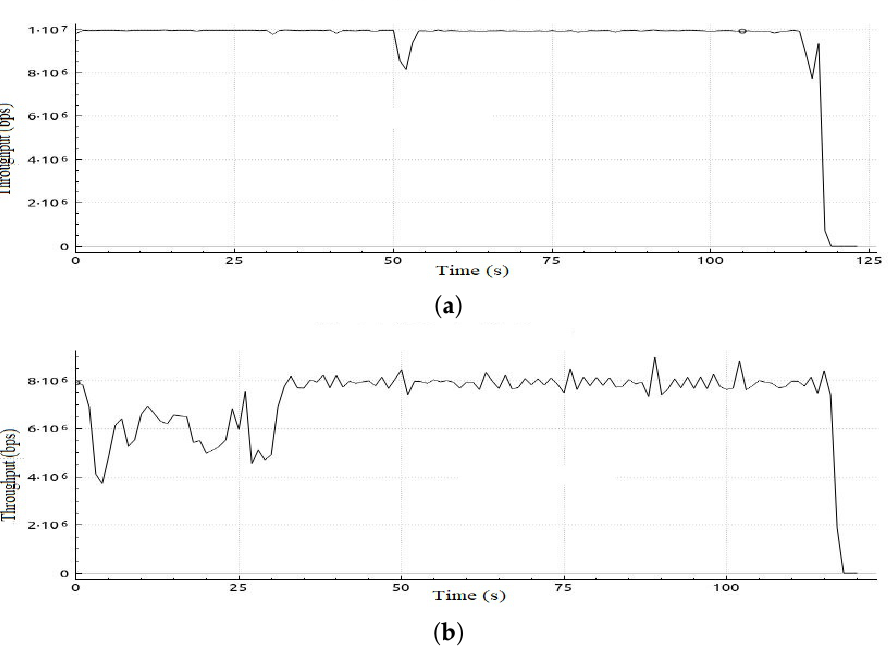
Figure 12. Throughput obtained in Scenario 2 in case of applying and without applying proposed adaptive QoS model for 120-s VoIP traffic flow, ( a ) Throughput obtained in Scenario 2 in case of applying proposed model, ( b ) Throughput obtained in Scenario 2 without applying proposed adaptive QoS